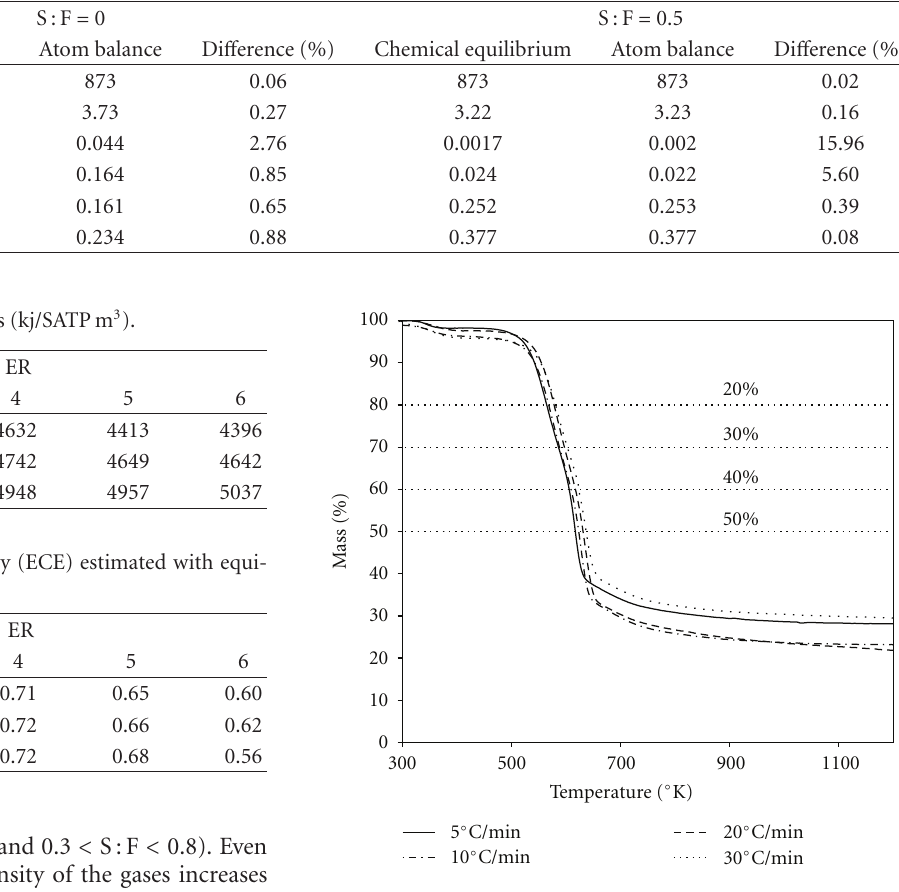
Figure 8: Thermogravimetric analysis of the co ff ee husk pyrolisys at di ff erent heating rates, adapted from